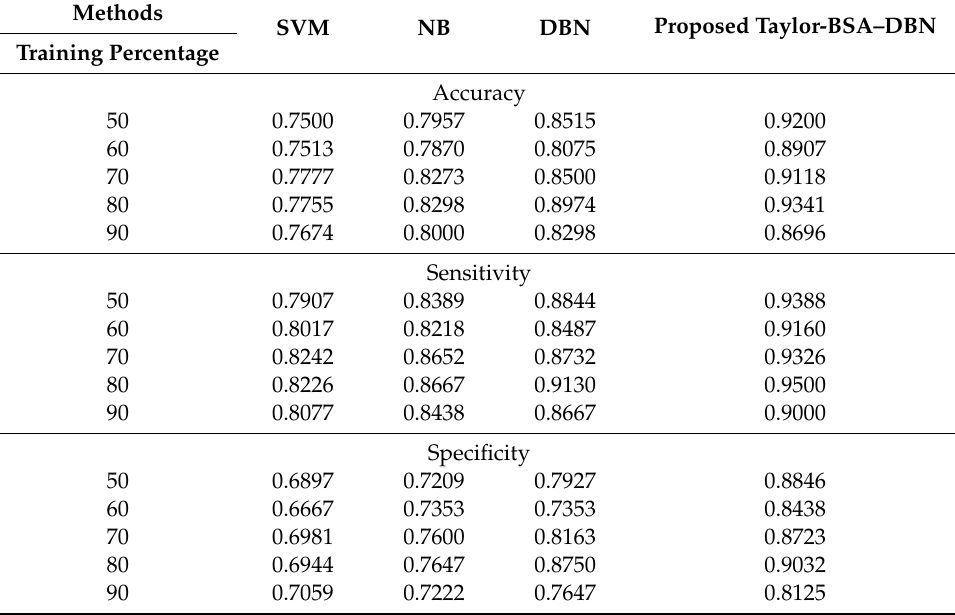
Table 6. Analysis of methods with cluster size = 9 using the Hungarian